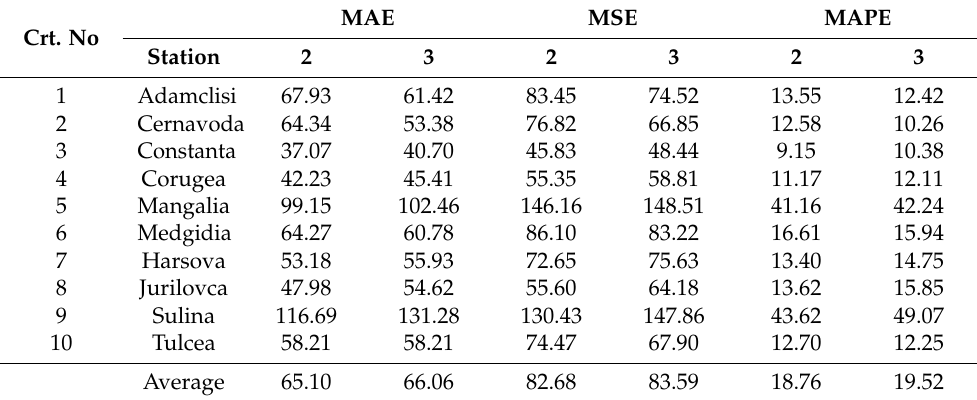
Table 3. The goodness of fit indicators in Methods II with two and three clusters for annual precipitation. Crt.